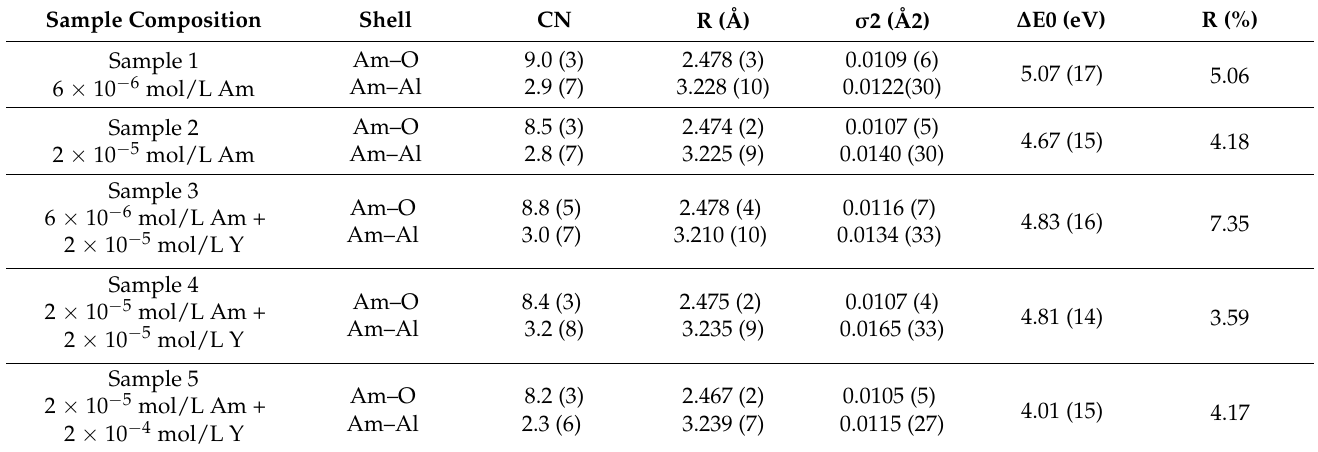
Table 4. Structural parameters derived from the k 3 -weighted EXAFS spectra for the Am L III edge. EXAFS fitting was performed over the k range of 1.6–10.5 Å − 1 using a constant amplitude reduction factor (S 02 ) of 0.9. CN: coordination number, R: radial distance, σ 2 : Debye–Waller factor, R % : fitting residual. Values in parenthesis are the calculated confidence limits of the fitted parameters.